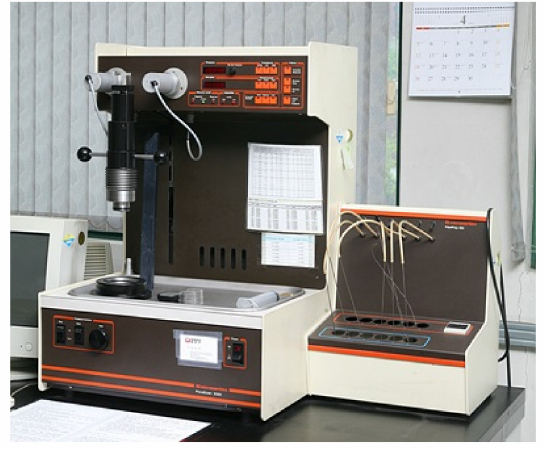
Figure 7. MIP distribution measuring